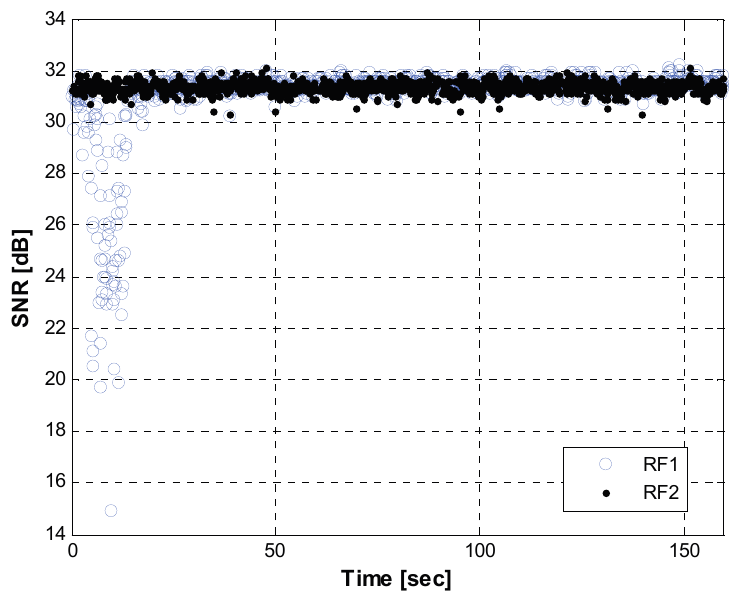
Figure 15. Received signal power transmitted from the master station while hovering.